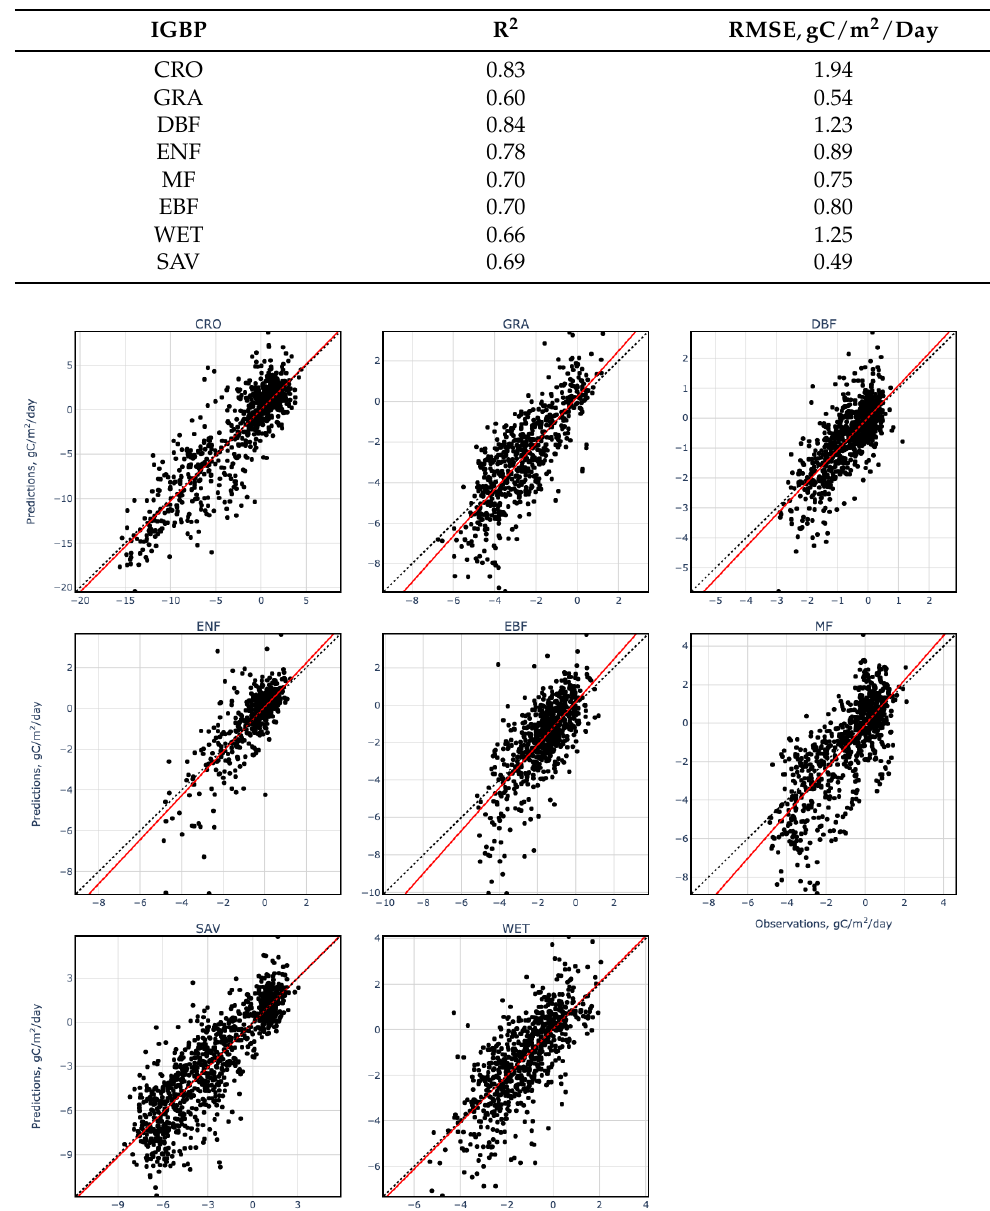
Table 5. Cross-validation metrics for monthly NEE values per land-cover class.